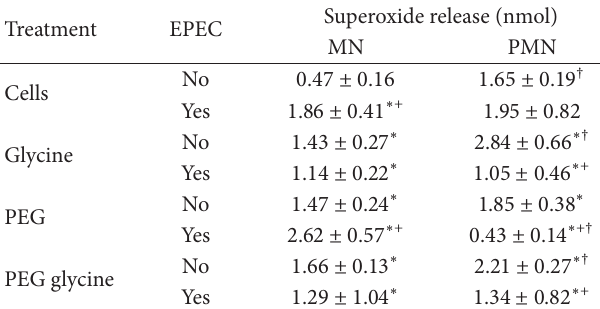
Table 1: Superoxide release by colostrum mononuclear (MN) and polymorphonuclear (PMN) cells (mean ± SD, 𝑁 = 10 in each